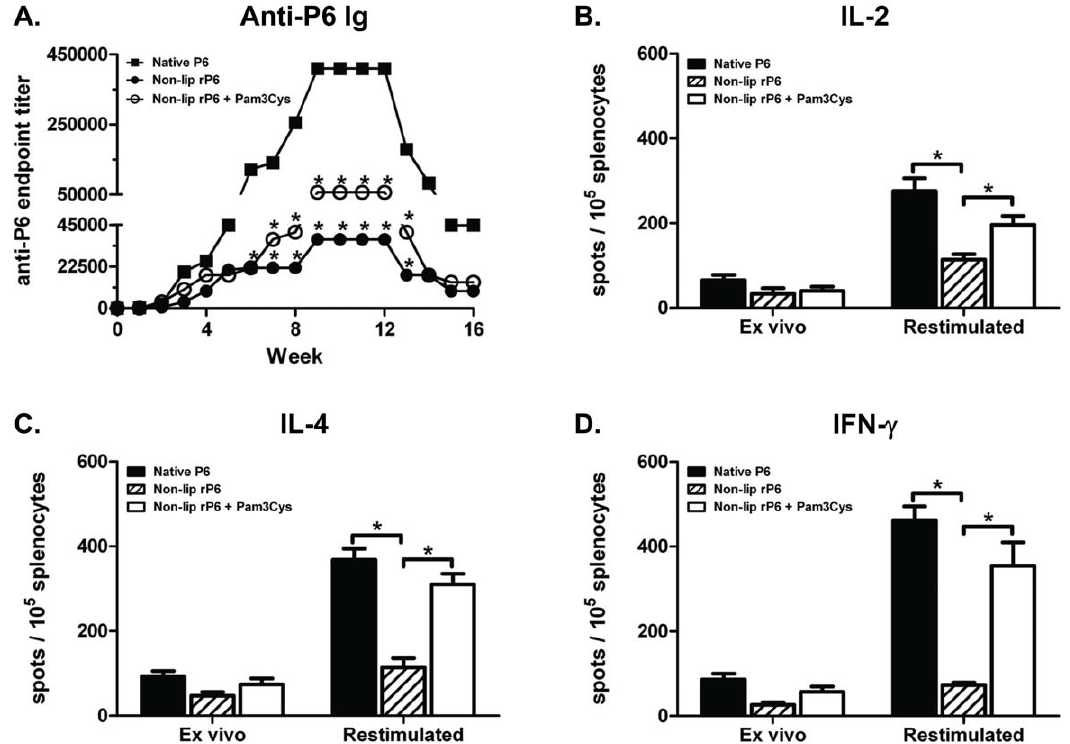
N ), or non-lipidated rP6 plus